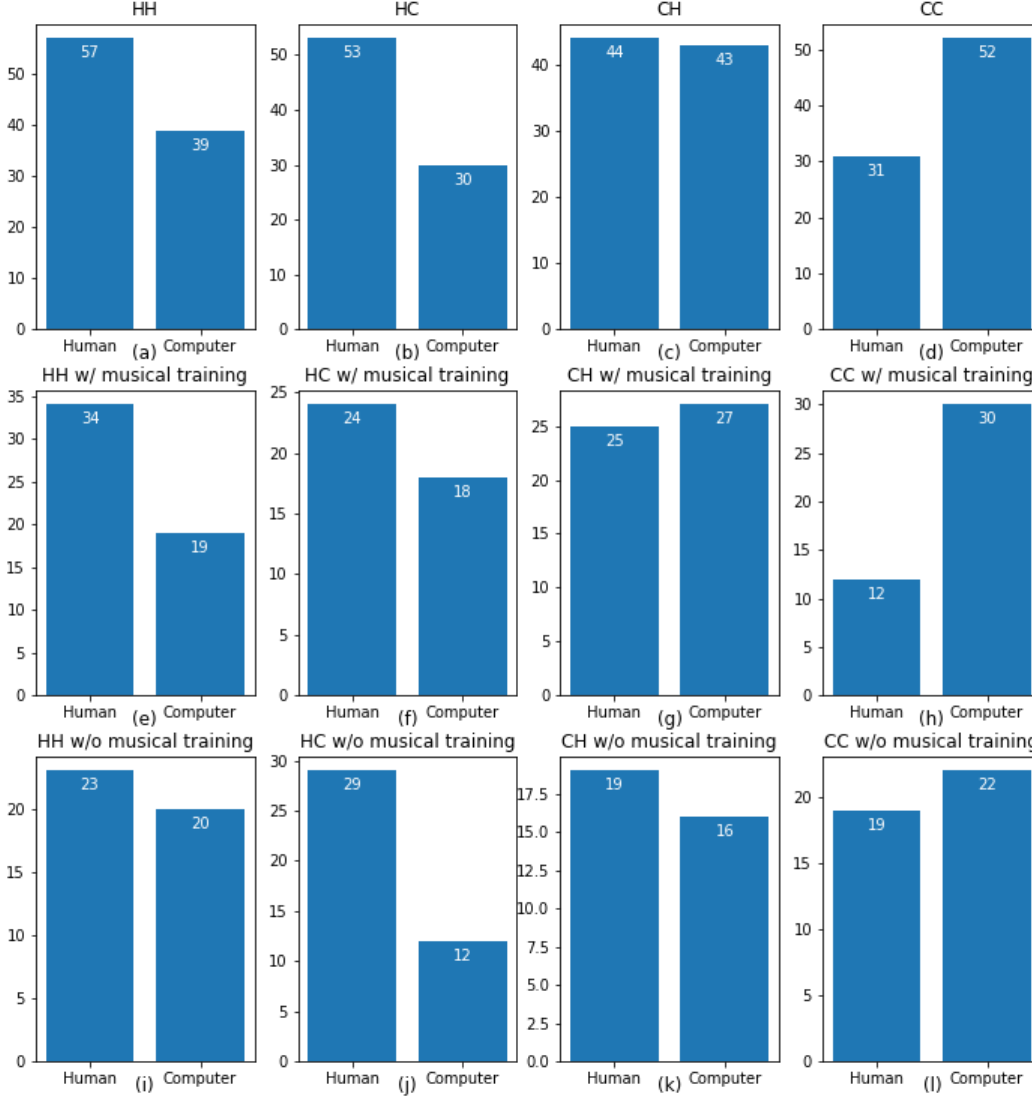
Figure 4. Number of participants in the considered groups (whole group, with musical training, and without musical training) who identified the composer of the music they listened to as Human or Computer. HH = music composed and performed by a human; HC = music composed by a human and performed by a machine; CH = music composed by a machine and performed by a human; CC = music composed and performed by a machine; w/ = with; w/o =